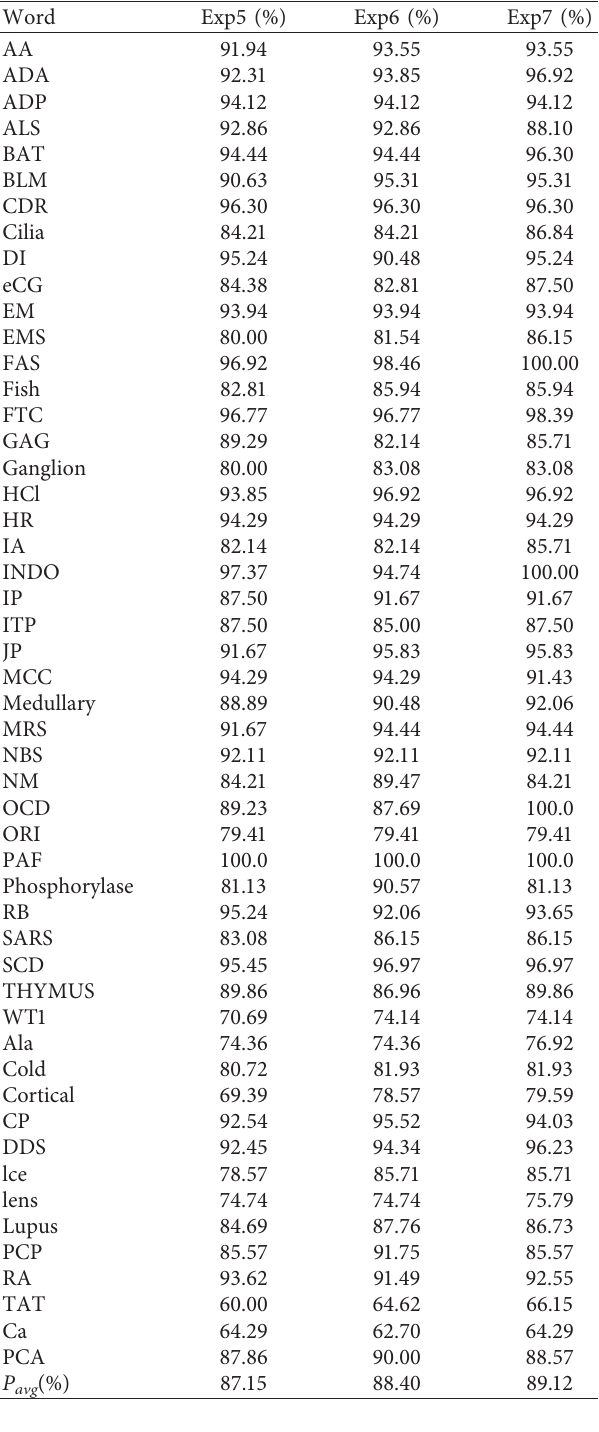
Table 2: Disambiguation accuracies from Experiment 5 to Ex- periment